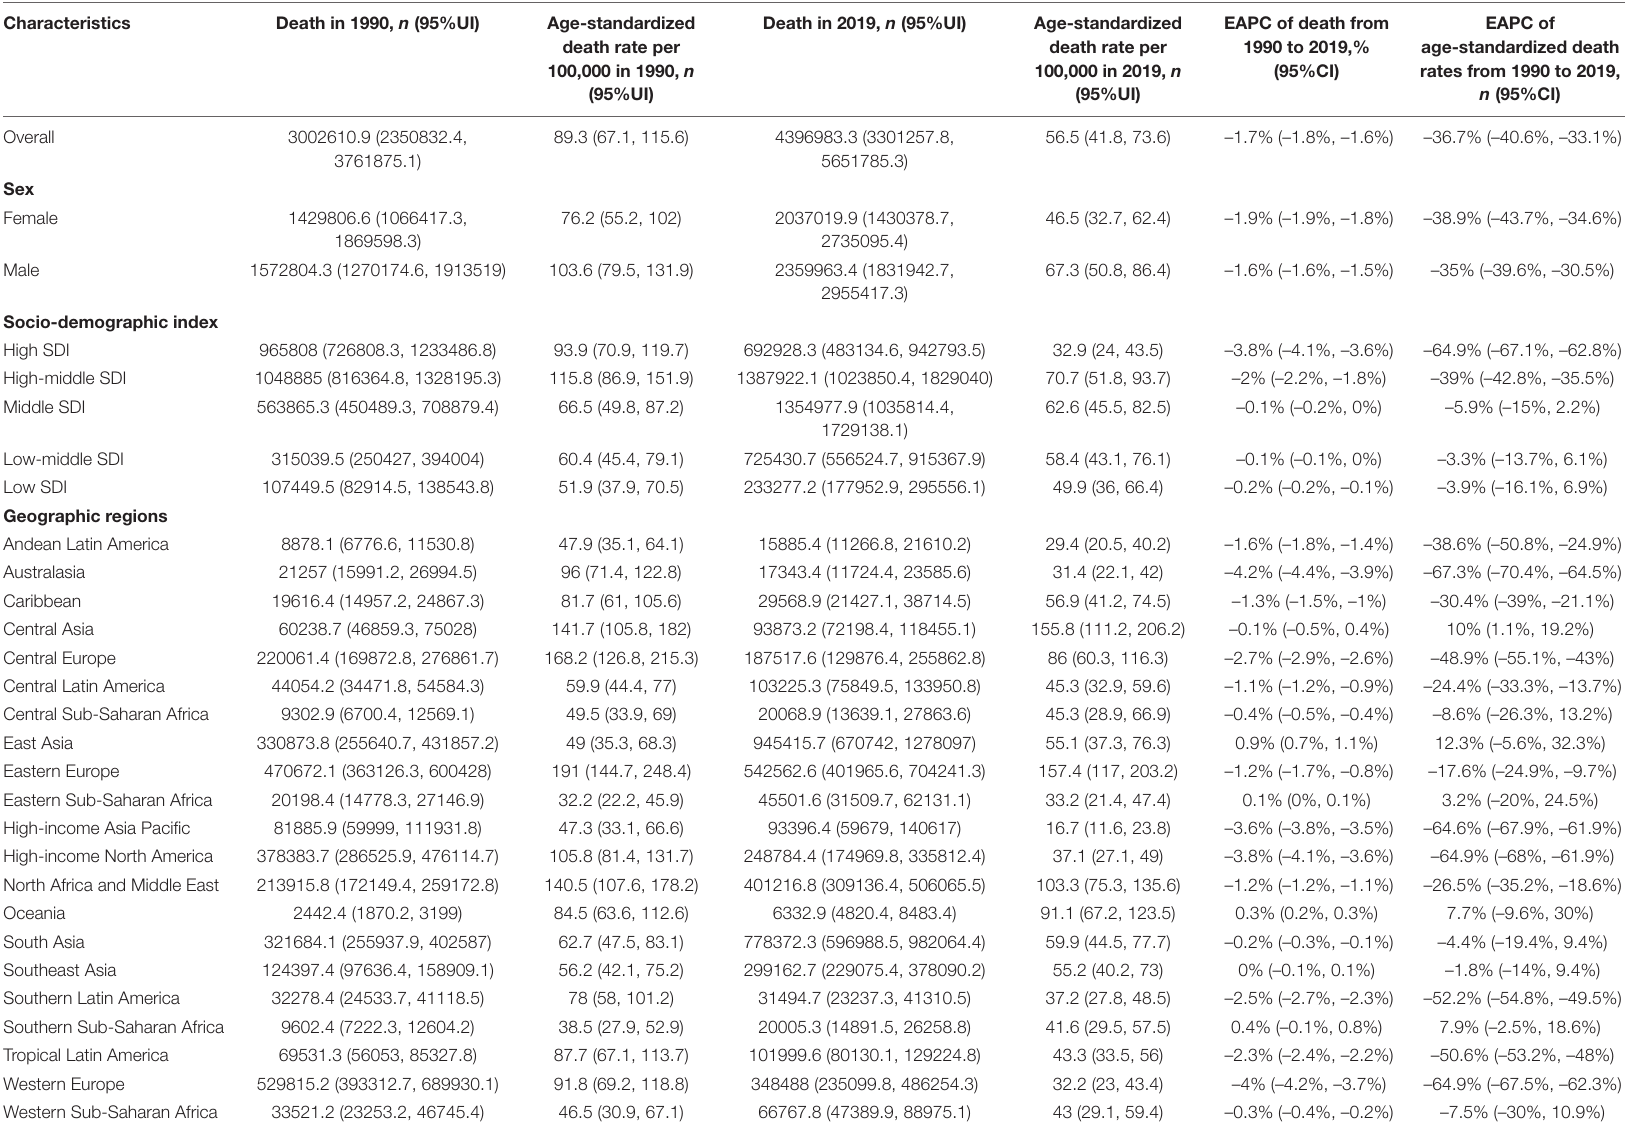
TABLE 2 | Trends of deaths and corresponding ASR attributable to high LDL-C in 1990 and